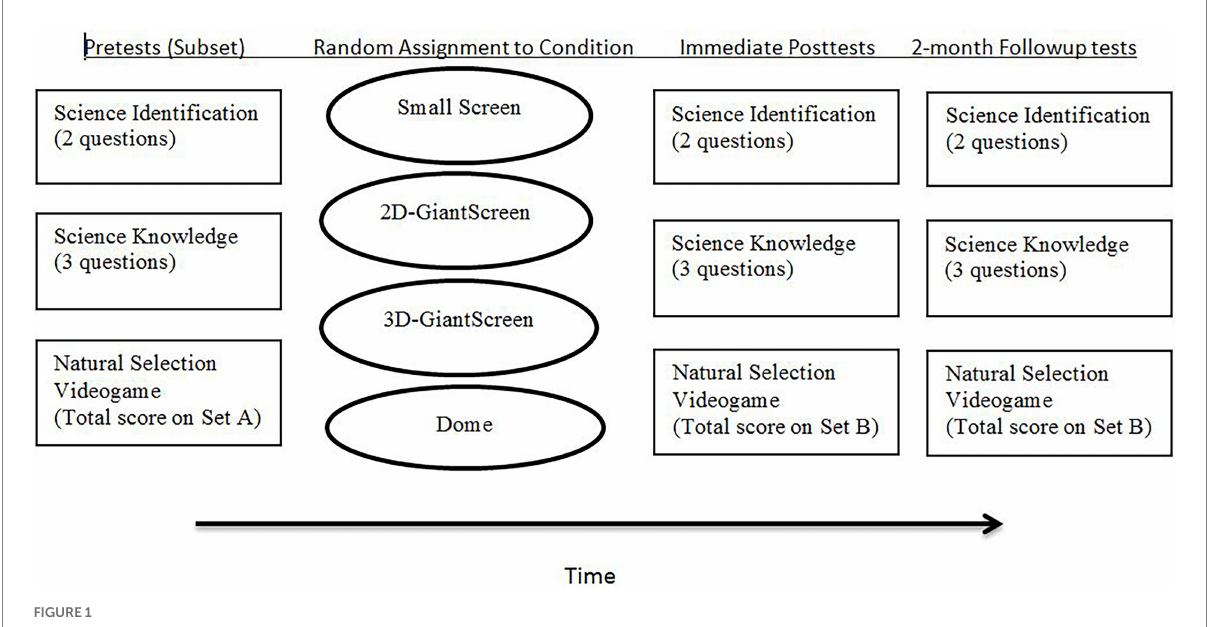
FIGURE 1 Schematic for the study’s